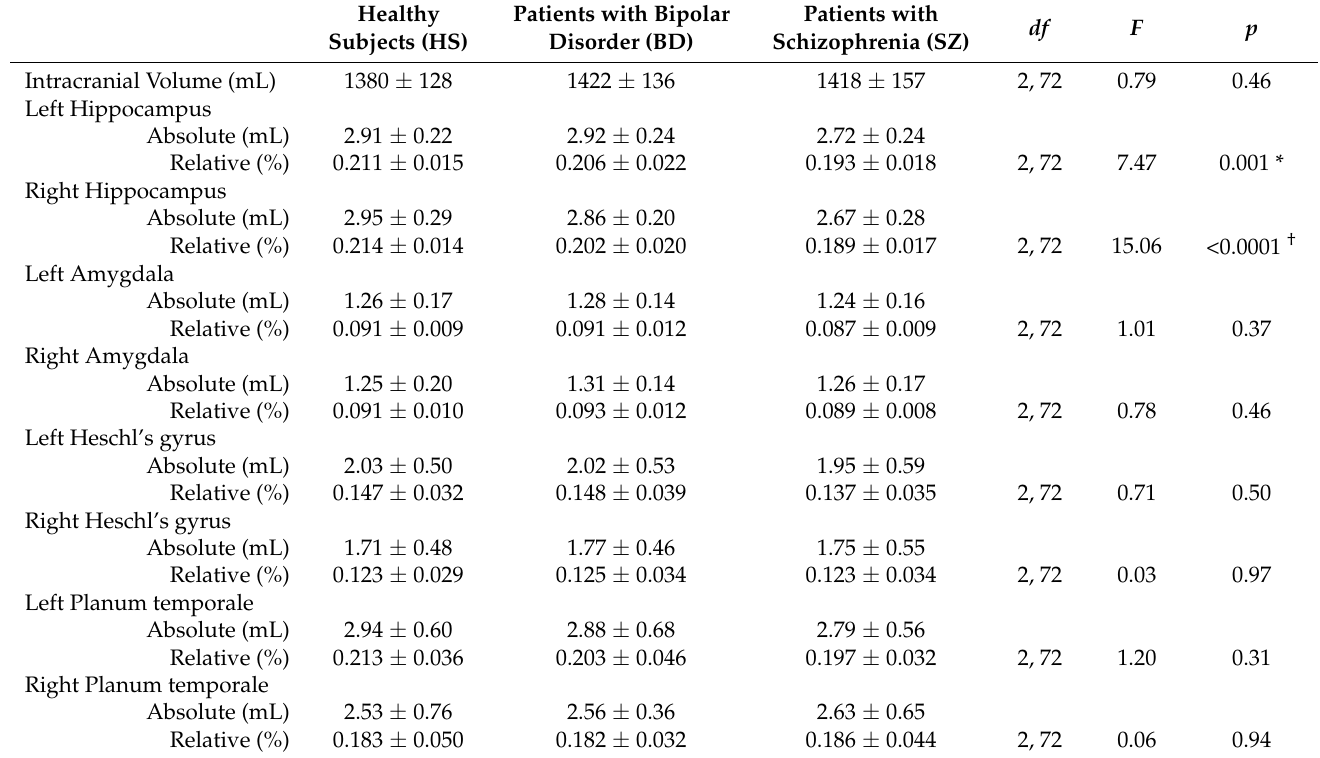
Table 2. Volume of each region of interest